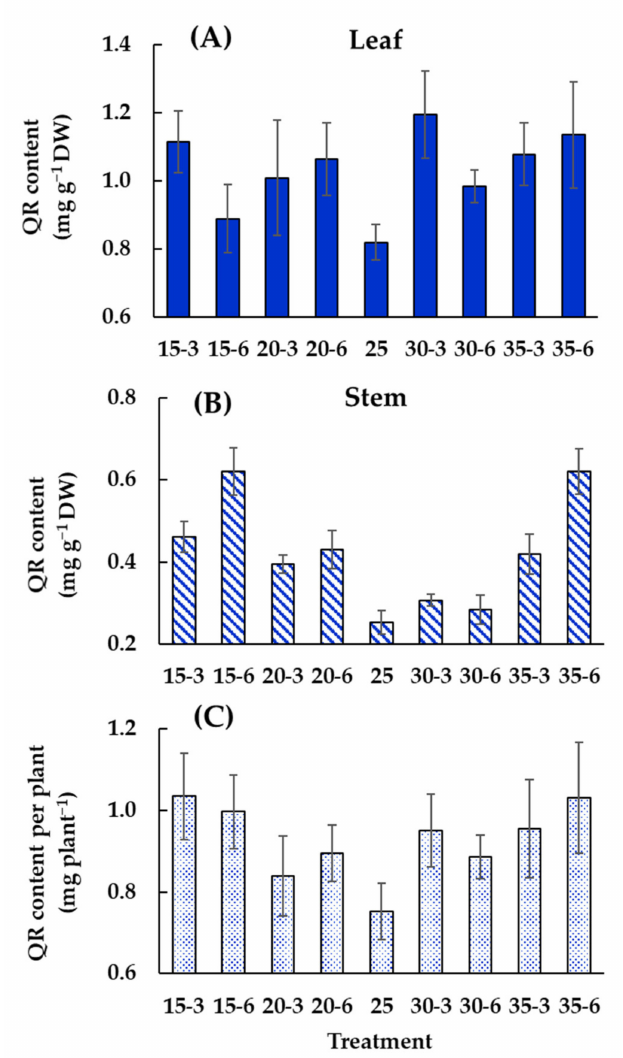
Figure 7. Rutin (QR) content per unit of leaf dry weight (DW) ( A ), QR content per unit of stem DW ( B ), and QR content per plant ( C ) in coriander plants after 18 days of cultivation under di ff erent root-zone temperatures and stress periods. Data are shown as the mean ± SE, n =